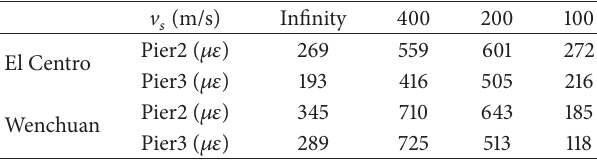
Table 3: Maximum strain at the bottom of Pier2 and